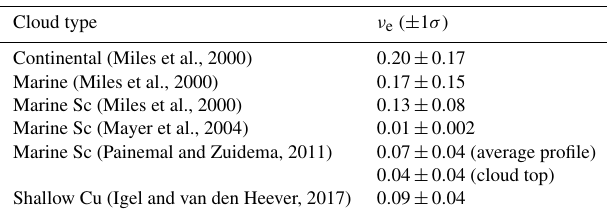
Table 2. Typical values and ranges of ν e found in observational studies and corresponding review